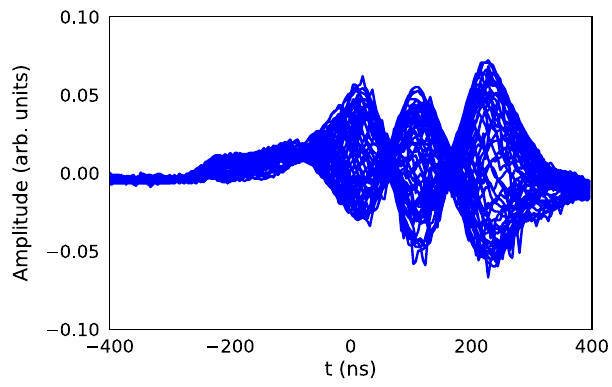
FIG. 14. Head-tail mode as recorded by the horizontal pick-up for a single bunch at ∼ 55 MeV. A radial mode m ¼ 2 is detected at this energy for the first time in the PSB, following the prediction based on Sacherer ’ s formalism. Chromaticity ξ x is close to the natural value.